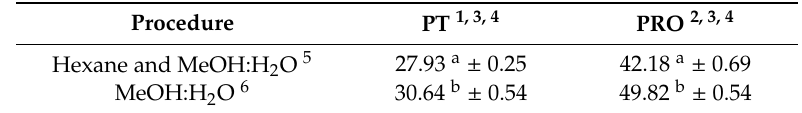
Table 1. Total phenolic and total flavan-3-ols determination in a commercial sample of U. tomentosa for defatting and non-defatting procedures.